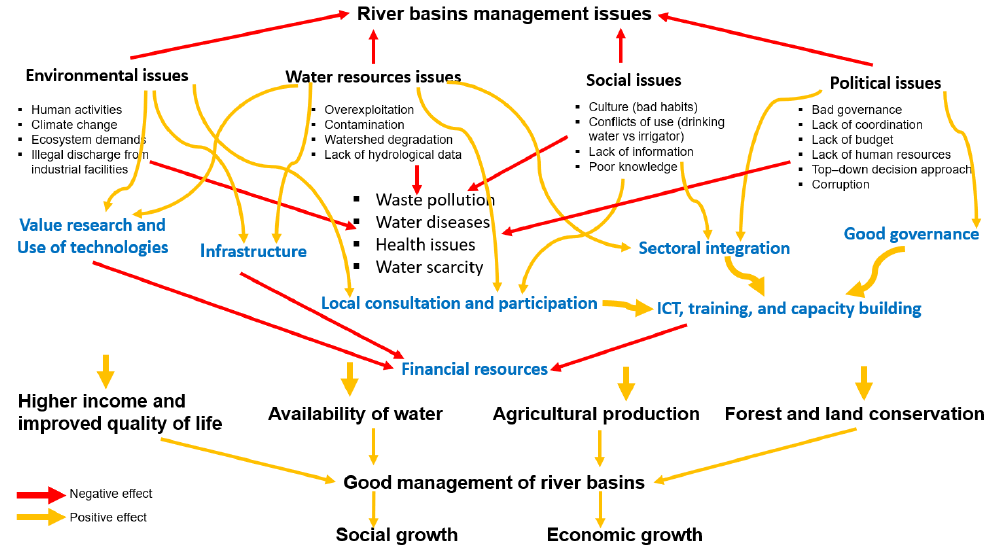
Figure 4. Example of the systemic thinking approach to IWRM in Madagascar.